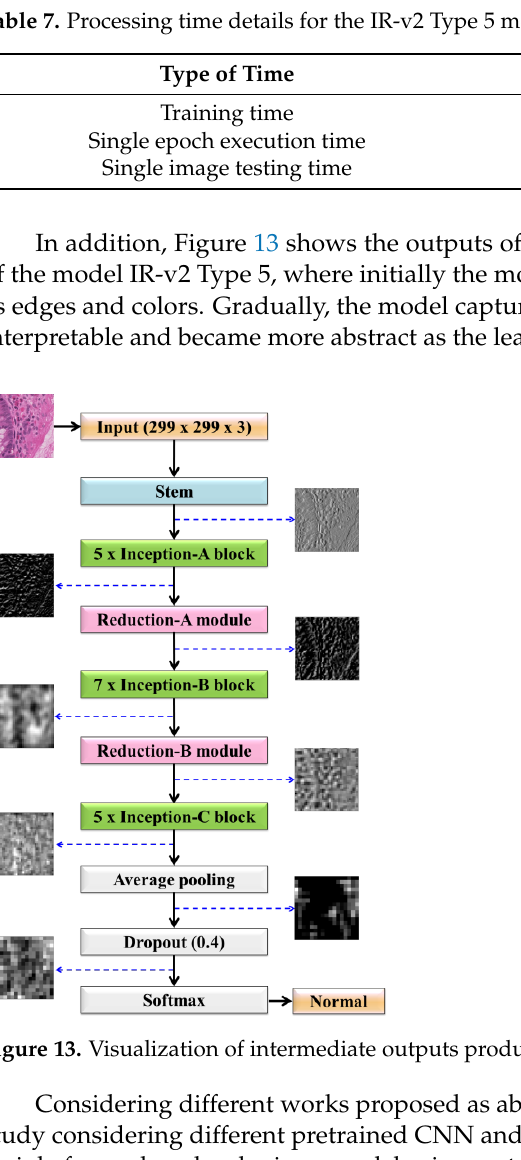
Figure 12. Comparison of outputs generated by the models: column 1: input image; column 2: classified outputs produced by EfficientNet; column 3: classified outputs produced by Inception-v3; and column 4: classified outputs produced by IR- v2 Type 5.